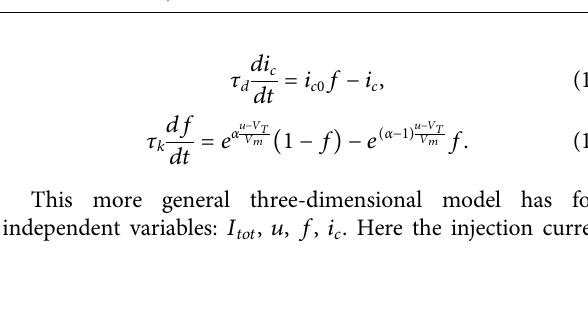
Frontiers in Energy Research |